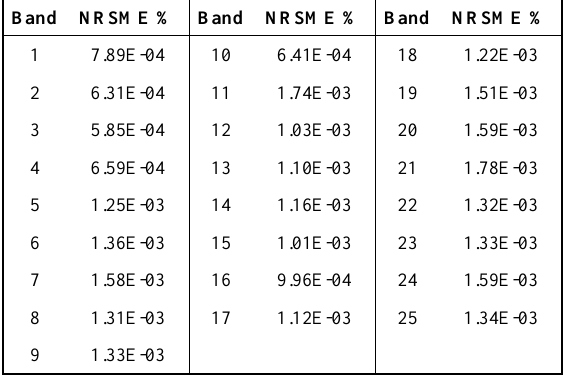
Table 4. NRMSE% obtained from the radiometric resolution